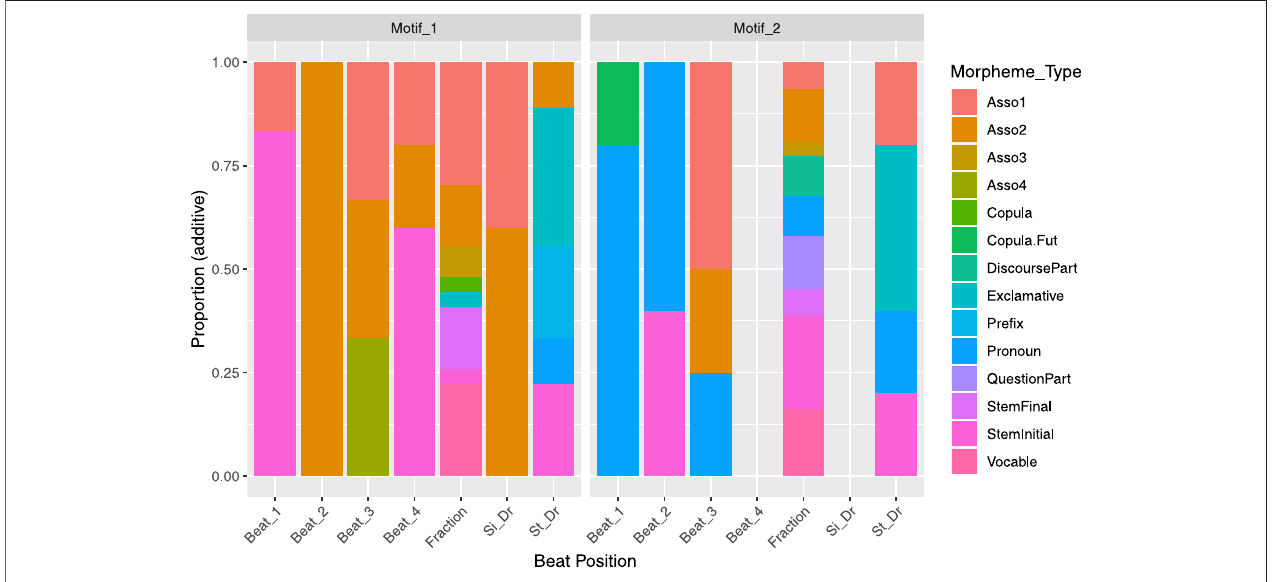
FIGURE 11 | Alignment of syllables by morpheme type and motif in master drummer ’ s verses of Song 1 represented as proportions of occurrences.